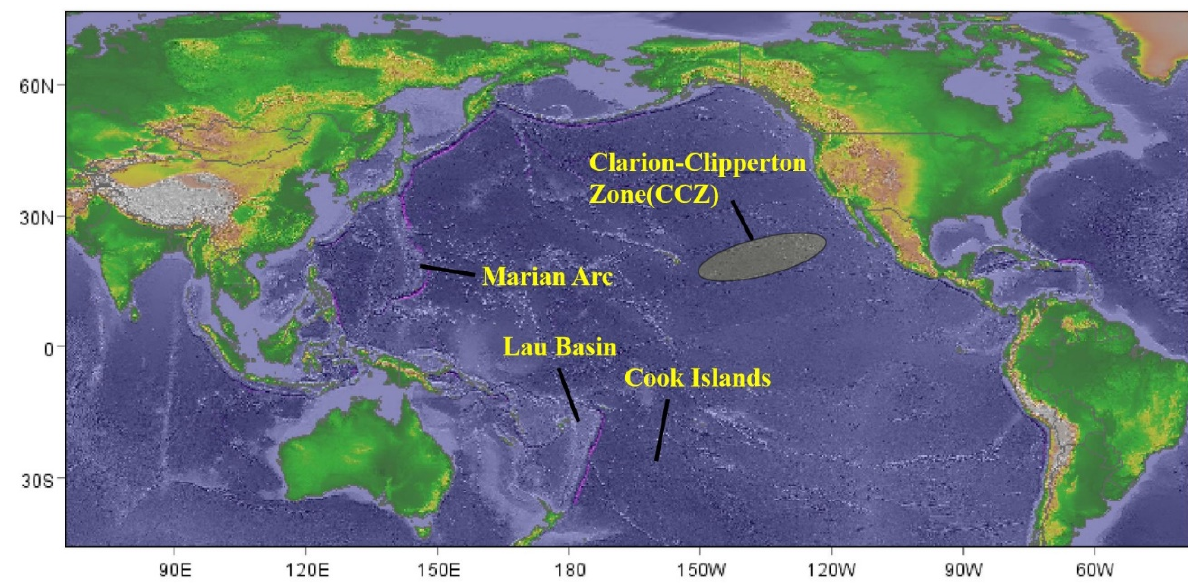
Figure 1. The location of Patania II in the North Pacific Ocean (map created by the authors).